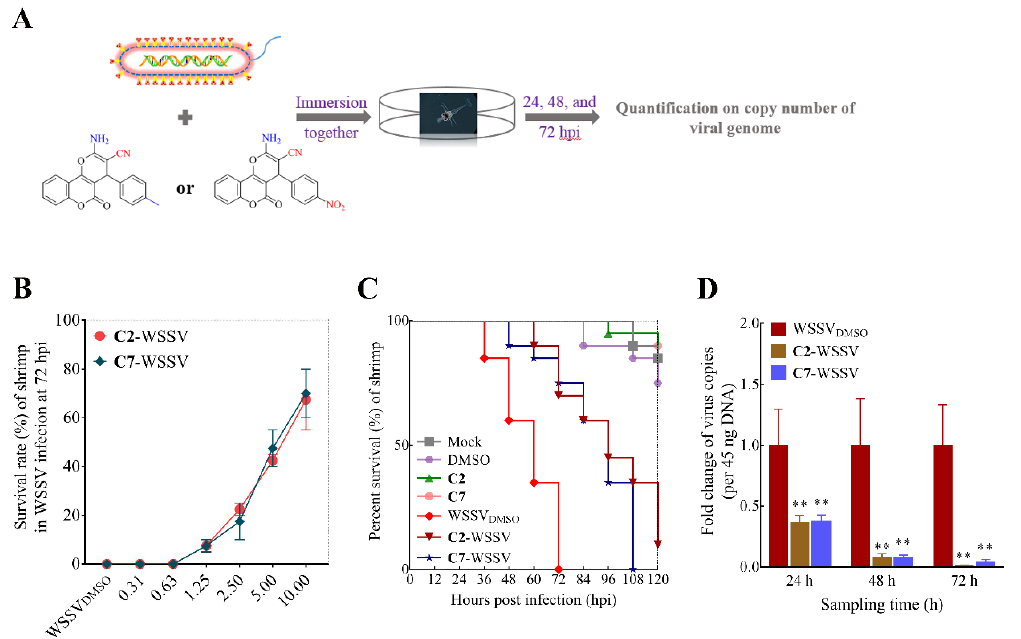
Figure 2. C2 and C7 inhibited WSSV infection in shrimp larvae. ( A ) Schematic diagram describing the workflow. ( B ) The survival rate of WSSV-infected shrimp was analyzed in 0.31 to 10 mg/L treatments at 72 hpi. ( C ) Survivorship curve of WSSV-infected shrimp was analyzed in C2 and C7 up to 10 mg/L treatment. ( D ) Quantification on copy number of viral genome was tested by exposure to C2 and C7 up to 10 mg/L treatment at 24, 48, and 72 hpi, respectively. The virus-infected shrimps were immersed with the compounds and DMSO at the dose 0.2‰ ( v/v ). Each value is represented as the mean ± SD normalized to values for no treatment. The p value for each study was determined by Student’s t tests. ** p < 0.01.